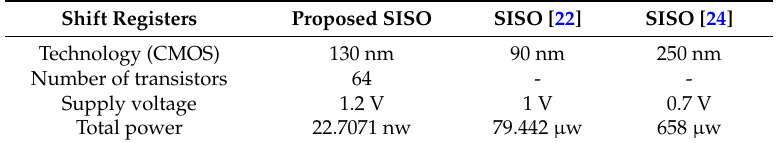
Table 3. Performance comparison among different serial in–serial out (SISO) shift registers.